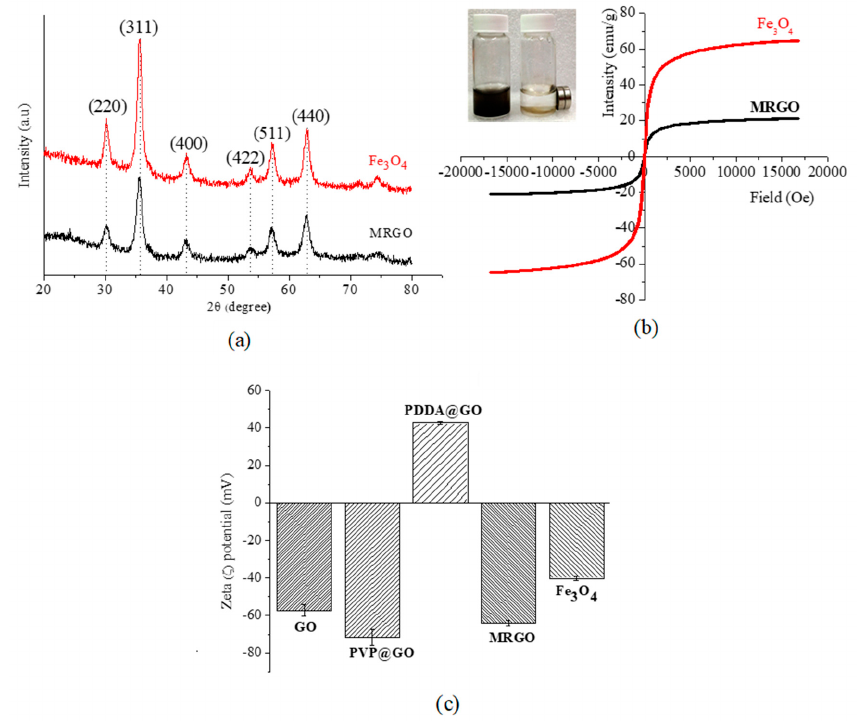
Figure 4. ( a ) XRD pattern and ( b ) VSM curves for Fe 3 O 4 and MRGO; and ( c ) zeta potential for various as-prepared graphene and Fe 3 O 4